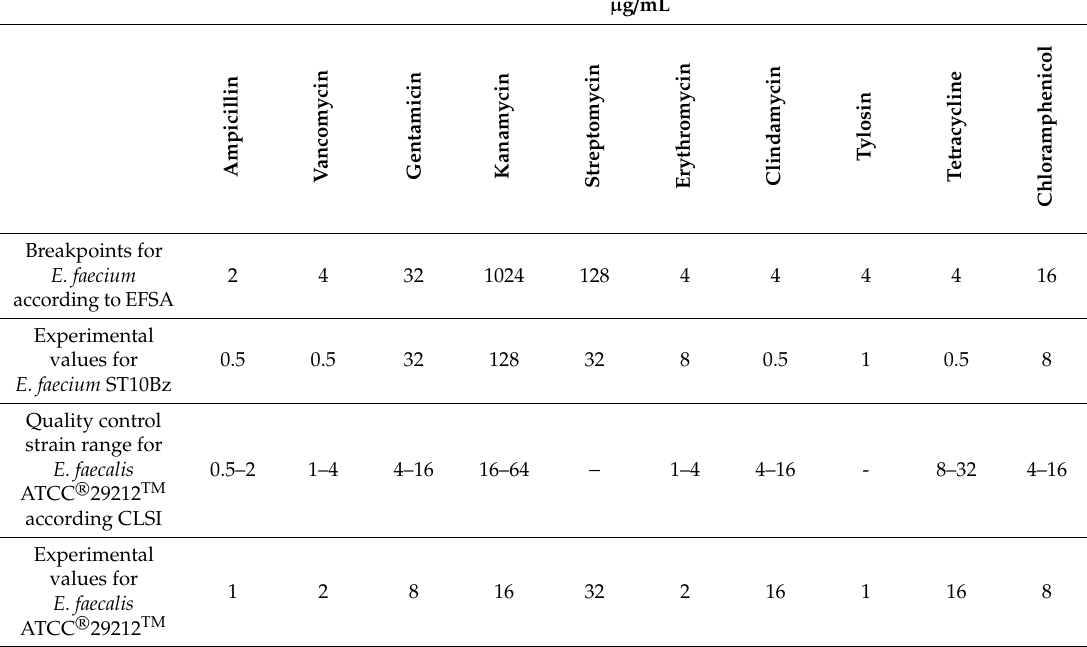
Table 1. Minimum inhibitory concentration of di ff erent antibiotics experimentally determined for breakpoints proposed by European Food Safety Authority EFSA and Clinical and Laboratory Standards Institute